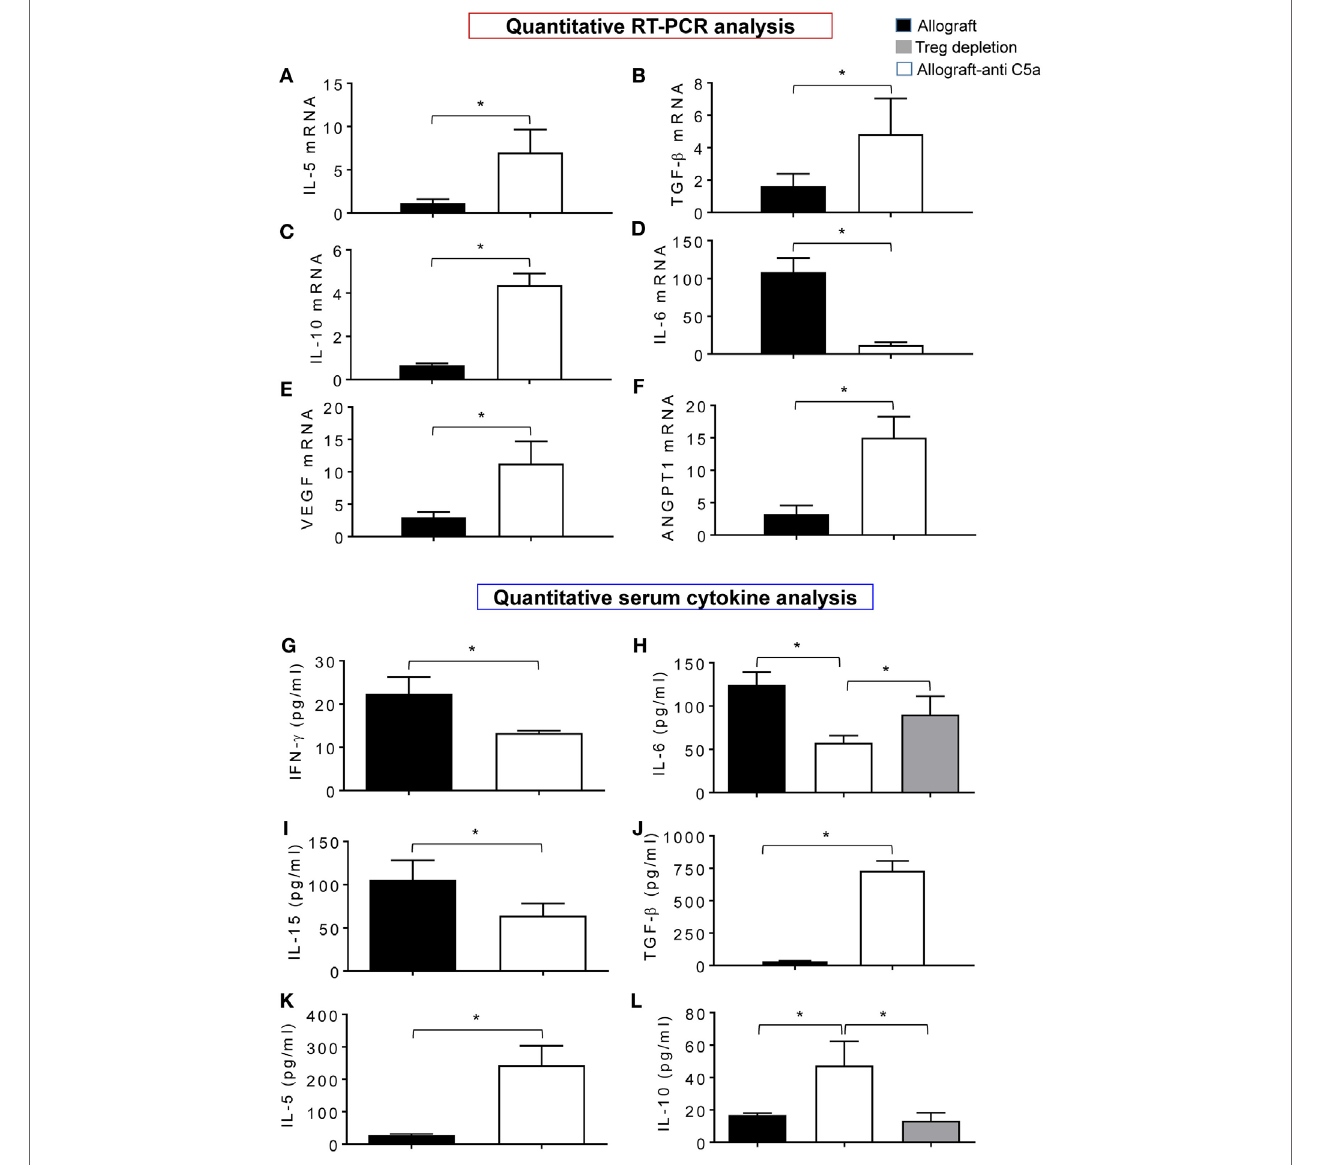
FigUre 6 | C5a inhibition promotes gene expression and anti-inflammatory cytokine. (a–F) Quantitative RT-PCR analysis shows fold change in regulatory and proangiogenic genes IL-5, TGF- β , IL-10, IL-6, vascular endothelial growth factor (VEGF), and AGPT1 mRNA at d10 posttransplantation. (g–l) Quantitative analysis of serum cytokines (pg/ml) at d10 posttransplantation. Data are presented as means with SE of 3–4 transplants/time point/experiment, and repeats of three different